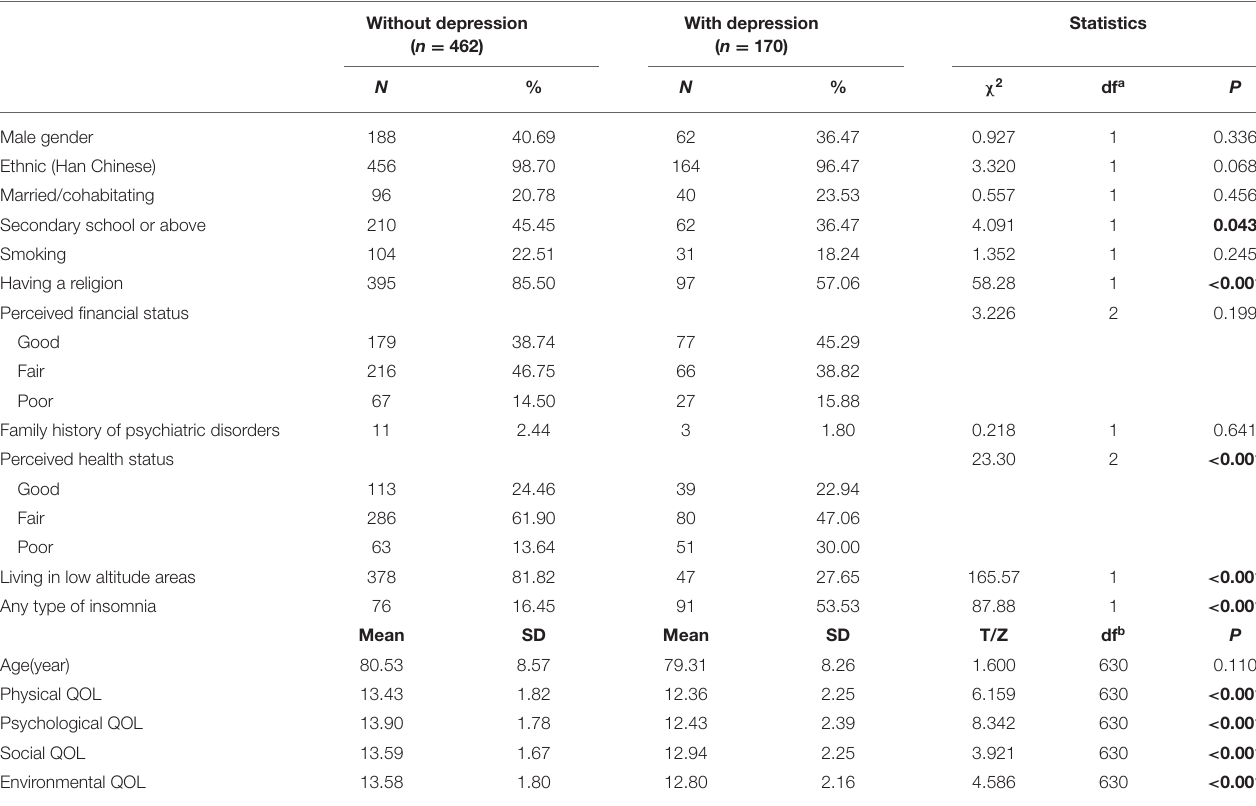
TABLE 2 | Comparison between older adults with and without depression in terms of basic demographic and clinical characteristics in the whole sample. Without depression With depression ( n = 462) ( n = 170)